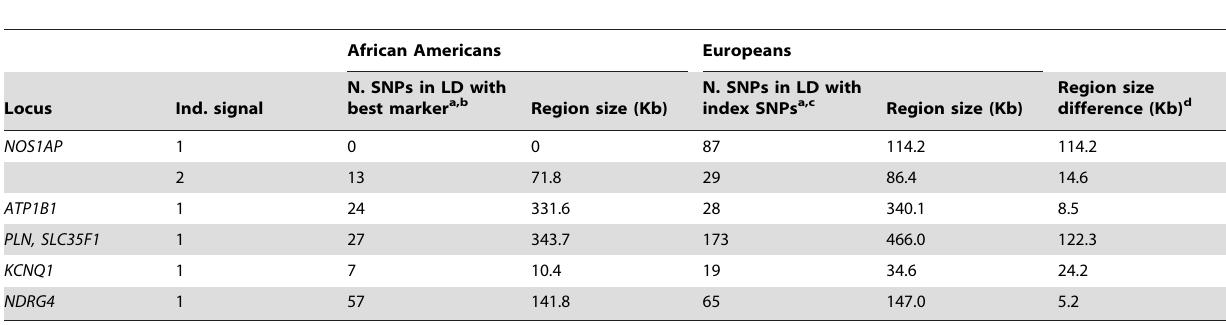
Table 3. Comparison of linkage disequilibrium patterns between populations of African and European descent for six previously identified QT loci significantly associated with QT in n=8,644 African American participants.